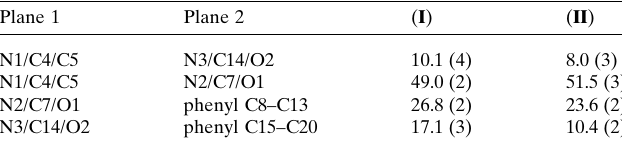
Table 1 Selected geometric parameters (A˚ , (cid:3) ) for ( I ).